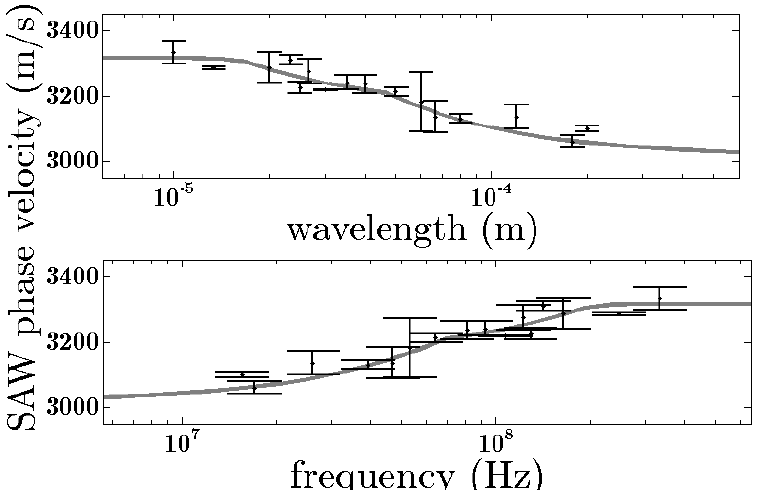
Figure 9. Experimental data obtained from the signal traces in Figure 8 and best parameter fitted coating-substrate dispersion curve (solid gray line), as a function of wavelength ( top ) and frequency ( bottom ). The fit was obtained by assuming a substrate’s Rayleigh velocity of 3024 m/s, taken from [42].